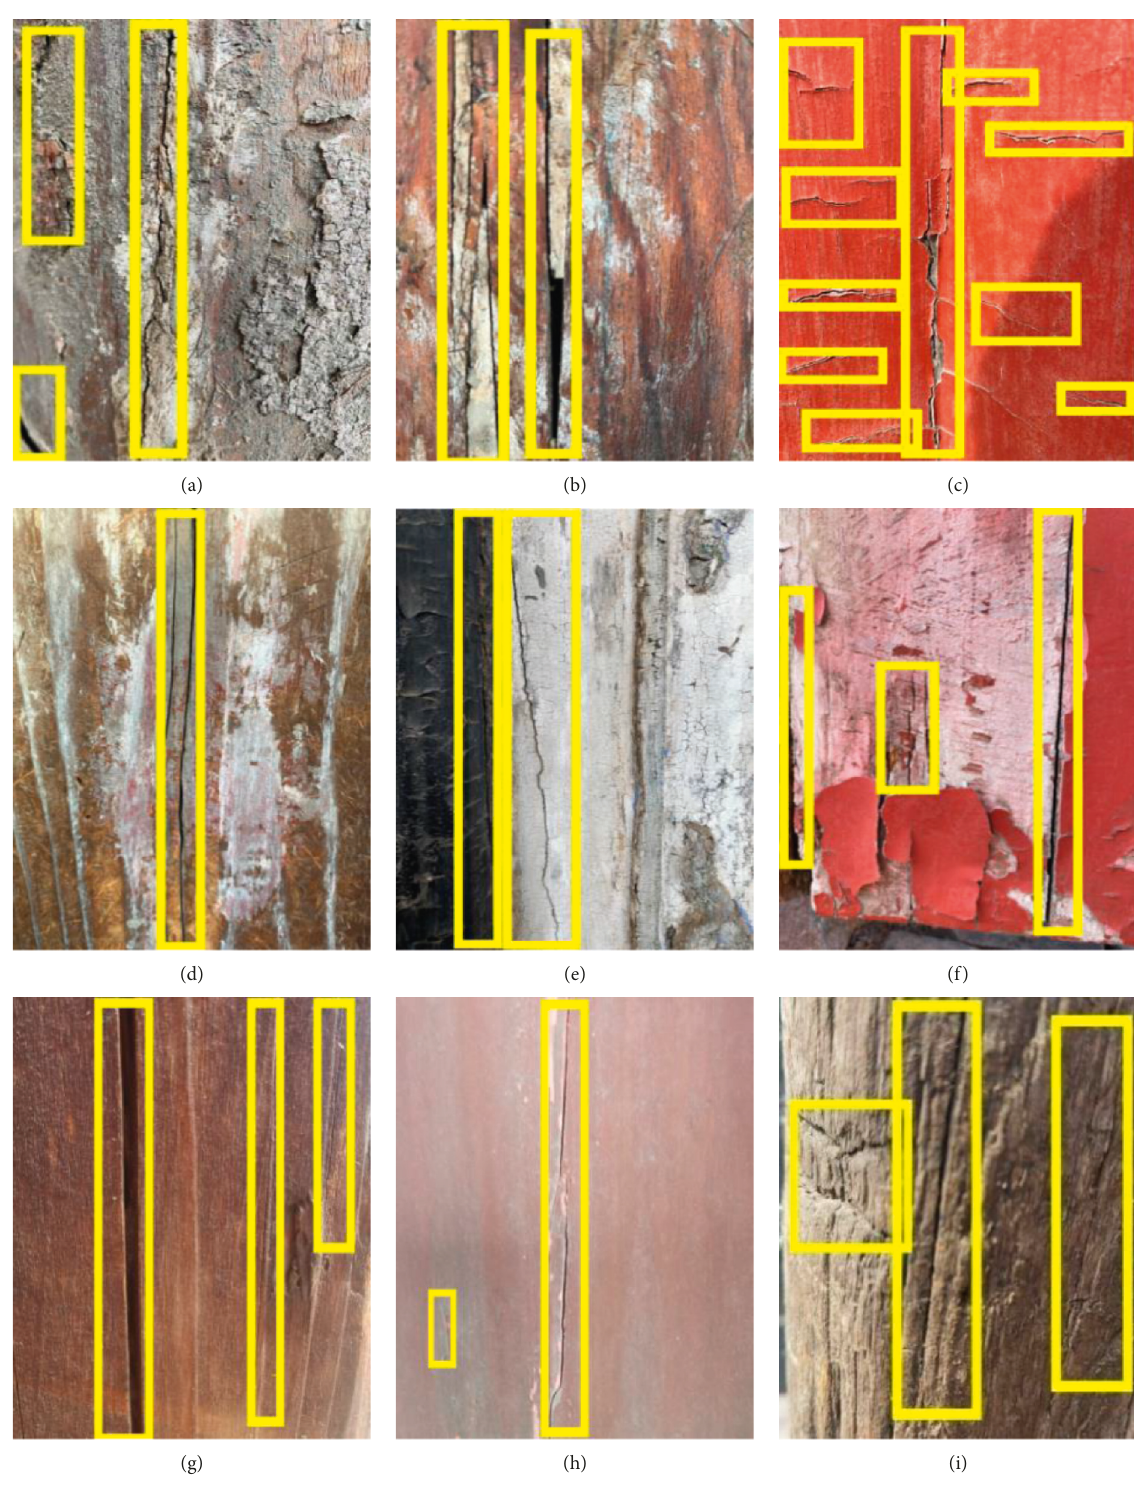
Figure 3: Different types of timber structure cracks in ancient architecture. (a) Type1 (b) type2 (c) type3, (d) type4 (e) type5 (f) type6, (g) type7 (h) type8 and (i)